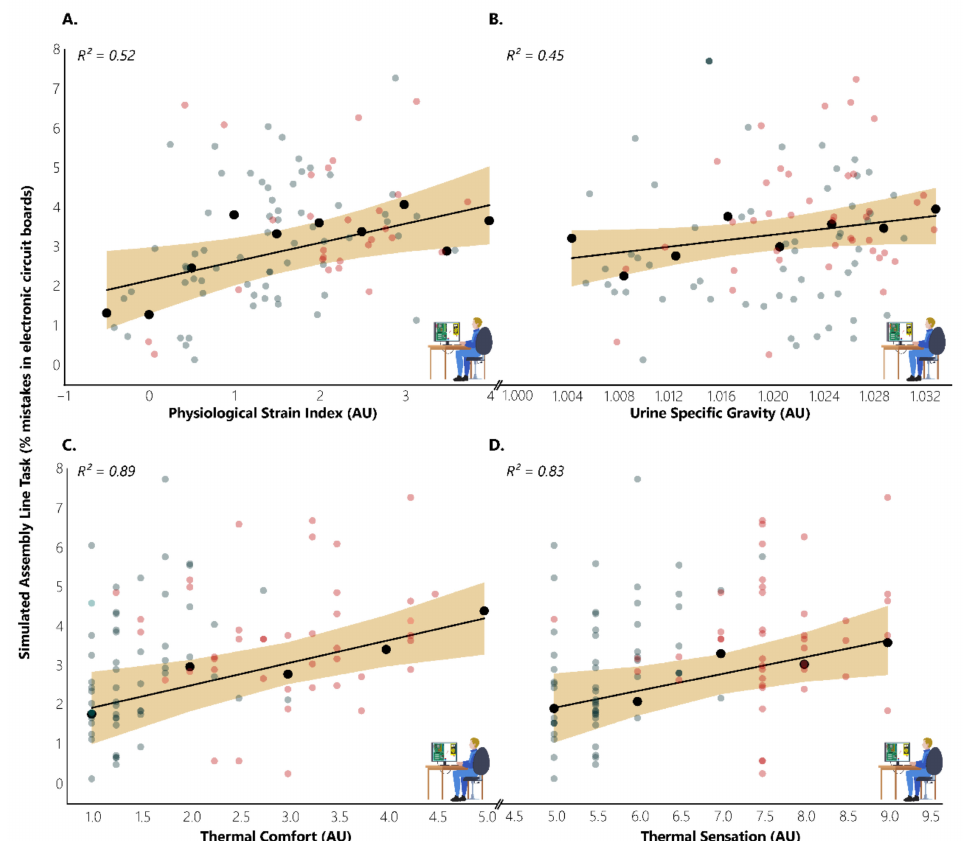
Figure 4. Impacts of physiological strain ( A ), hydration status ( B ), thermal comfort ( C ), and thermal sensation ( D ) on labour productivity, as expressed by physiological strain index, urine specific gravity, and the subjective scales of thermal comfort and thermal sensation, respectively. AU indicates arbitrary units. Red and blue dots represent work during hot (35.4 ◦ C) and neutral (25.4 ◦ C) conditions, respectively. Black dots with their accompanied trendline and 95% CI (shaded area) depict the increase in the number of mistakes committed in electronic circuit boards for every 0.5 points in physiological strain index, 0.004 points in the urine specific gravity scale, and 1 point in the subjective scales of thermal comfort and thermal